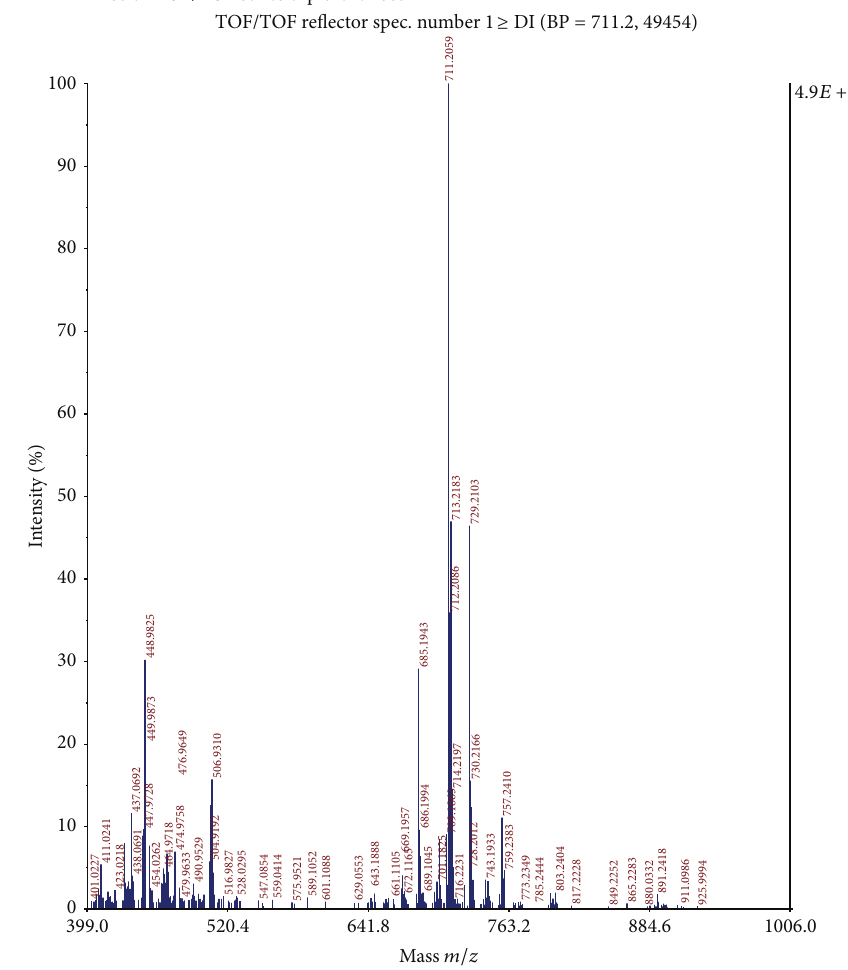
Figure 1: MALDI/MS spectrum of the SLJO preparation.